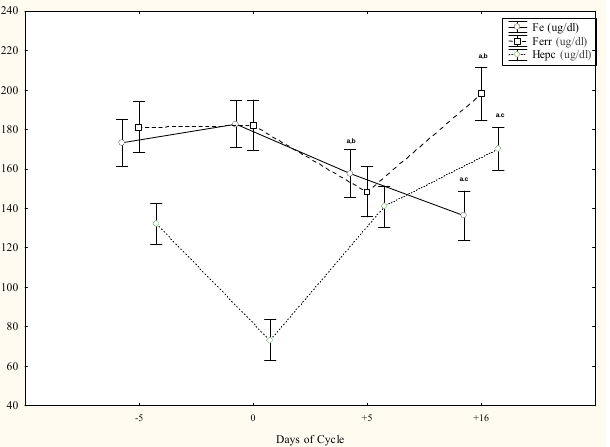
Figure 1. Circulating iron, ferritin, and hepcidin concentrations (mean ± SD) in cycling Spanish Purebred mares. Letters indicate significant differences among days: a vs. − 5; b vs. 0; c vs. +5 ( p < 0.05).